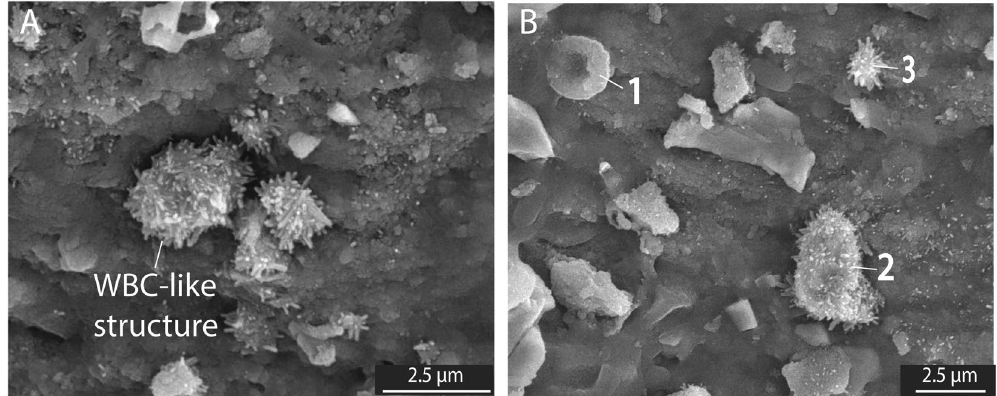
Figure 3. Secondary electron images of the trabecular bone following the removal of sparry calcite by light acetic acid revealing soft tissues. ( A ) Presence of WBC-like structures. ( B ) 1) indicates a RBC-like structure, 2) indicates a WBC-like structure and 3) indicates a platelet-like